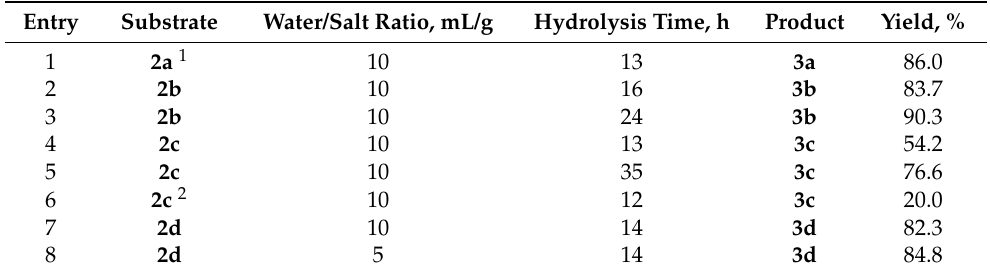
Table 2. Hydrolysis results for sulfuric acid salts of triaminobenzene